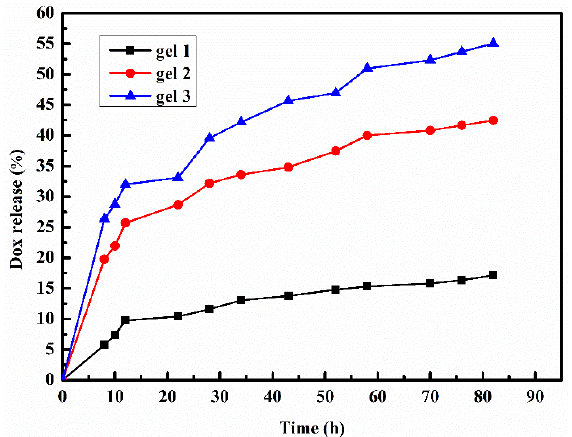
Figure 7. Drug release curves of the DOX-HCl-loaded hydrogels.